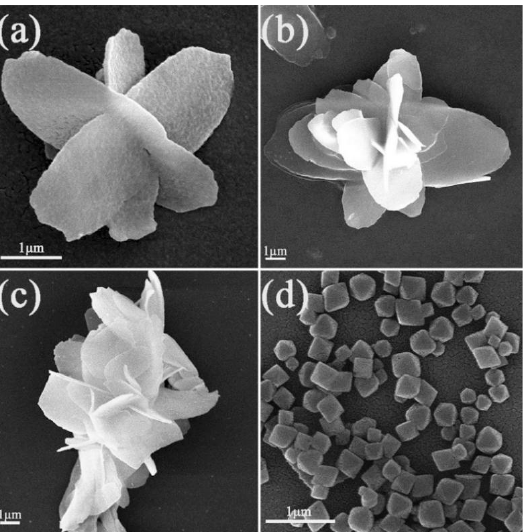
Figure 6. SEM images of ( a ) 350 °C CeO 2 , ( b ) 400 °C CeO 2 , ( c ) 450 °C CeO 2 , and ( d ) UiO-66-NH 2 .